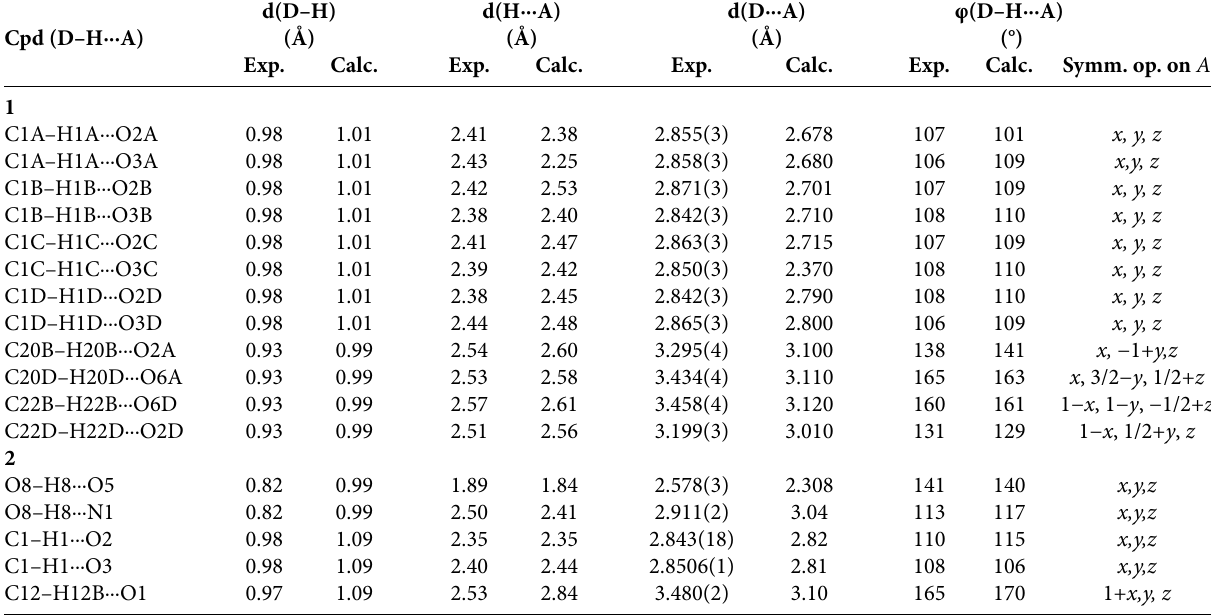
Table 2. Geometric parameters of hydrogen bonds and angles.